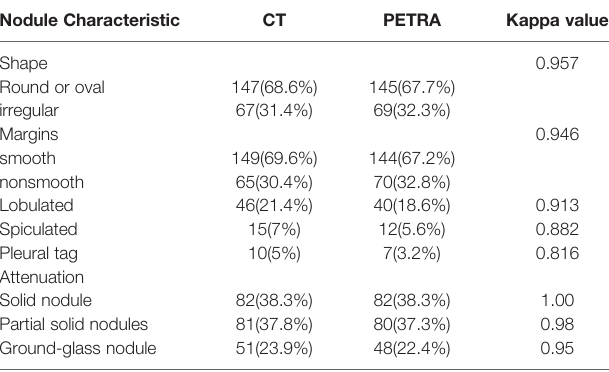
Data are number(%) of